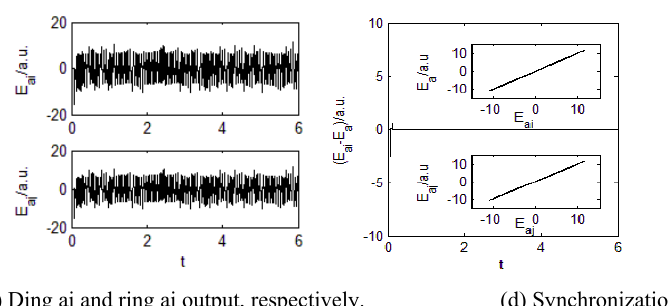
Fig. 3. The transmitter output, two receivers output, and the transmitter synchronizes with two receivers.